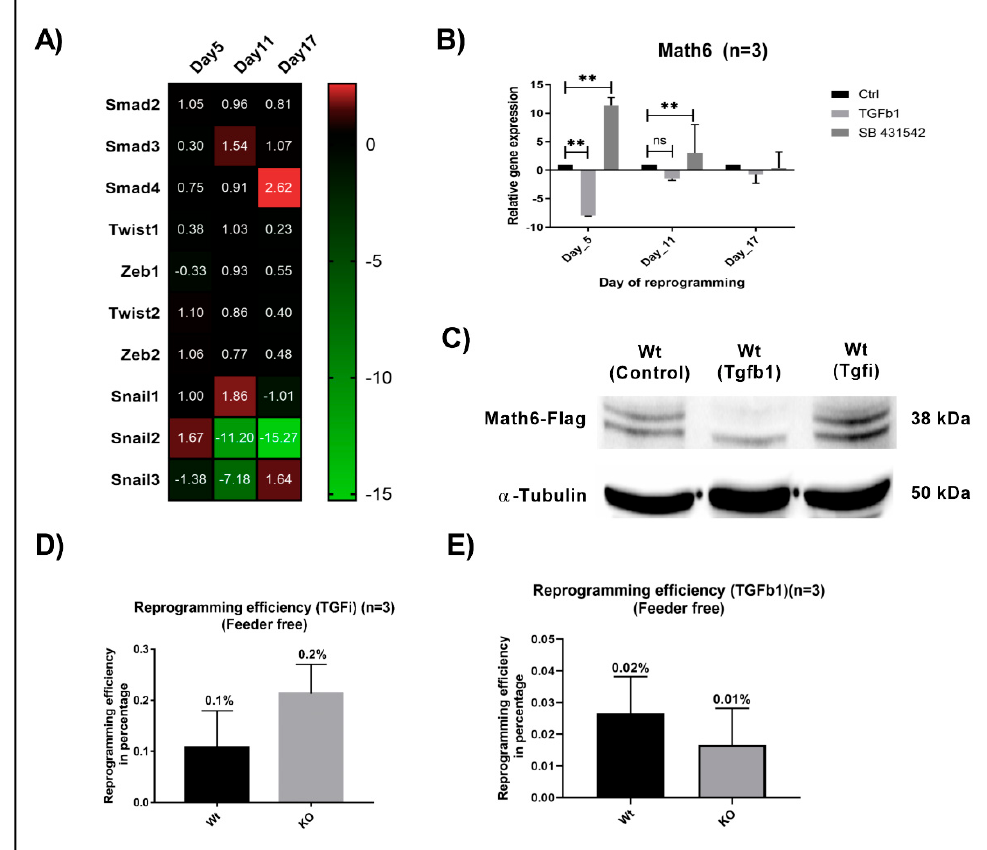
Figure 4. TGF- β signalling counteracts the promoting effect of Math6 on MET and somatic cell reprogramming. ( A ) Expression of pro-mesenchymal genes during different phases of